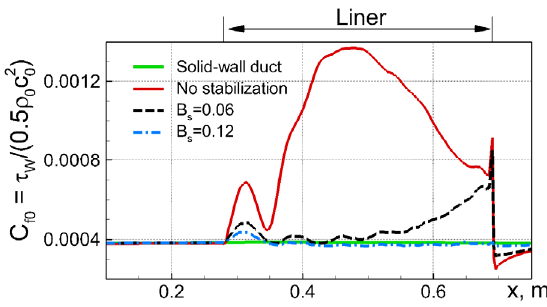
Figure 28. Effect of stabilization (10) and its amplitude parameter B s on mean skin-friction coefficient at upper wall of NASA GFIT.